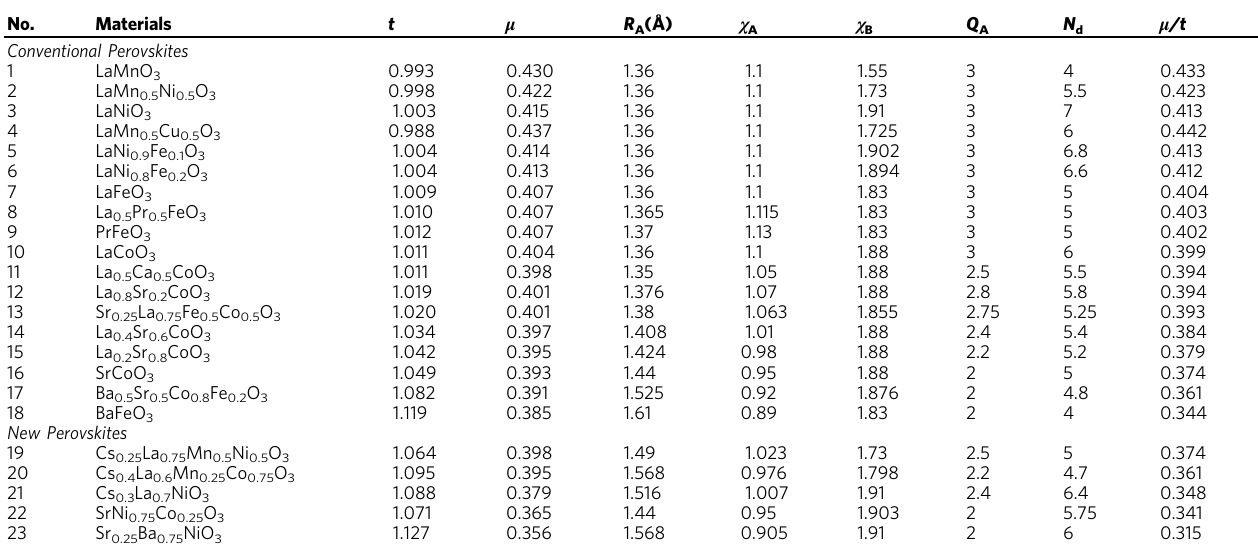
Table 1 Key materials parameters of 23 selected oxide perovskites. No.